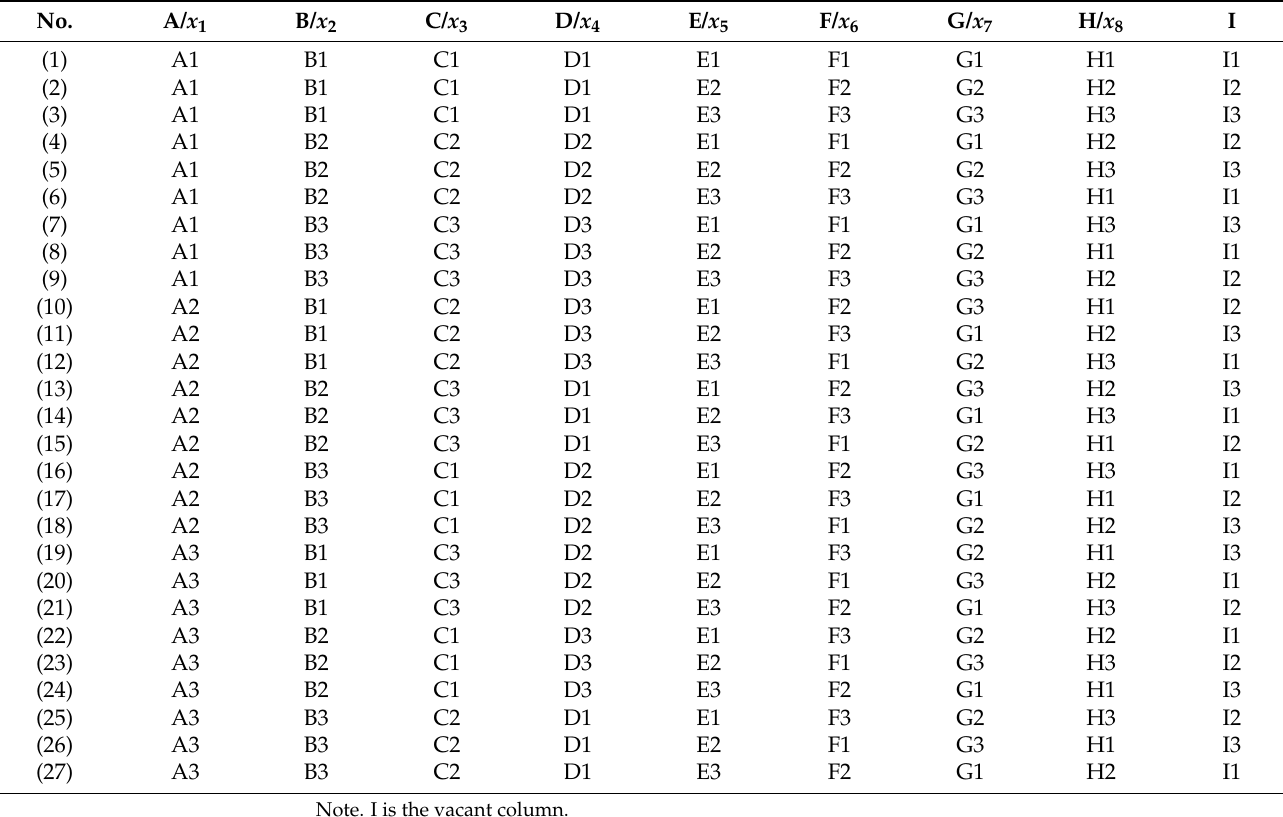
Table 6. Orthogonal experiment schemes.